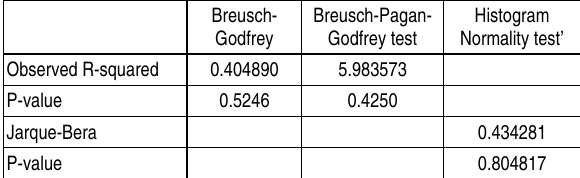
Table 3 . Diagnostic tests for regression model 2